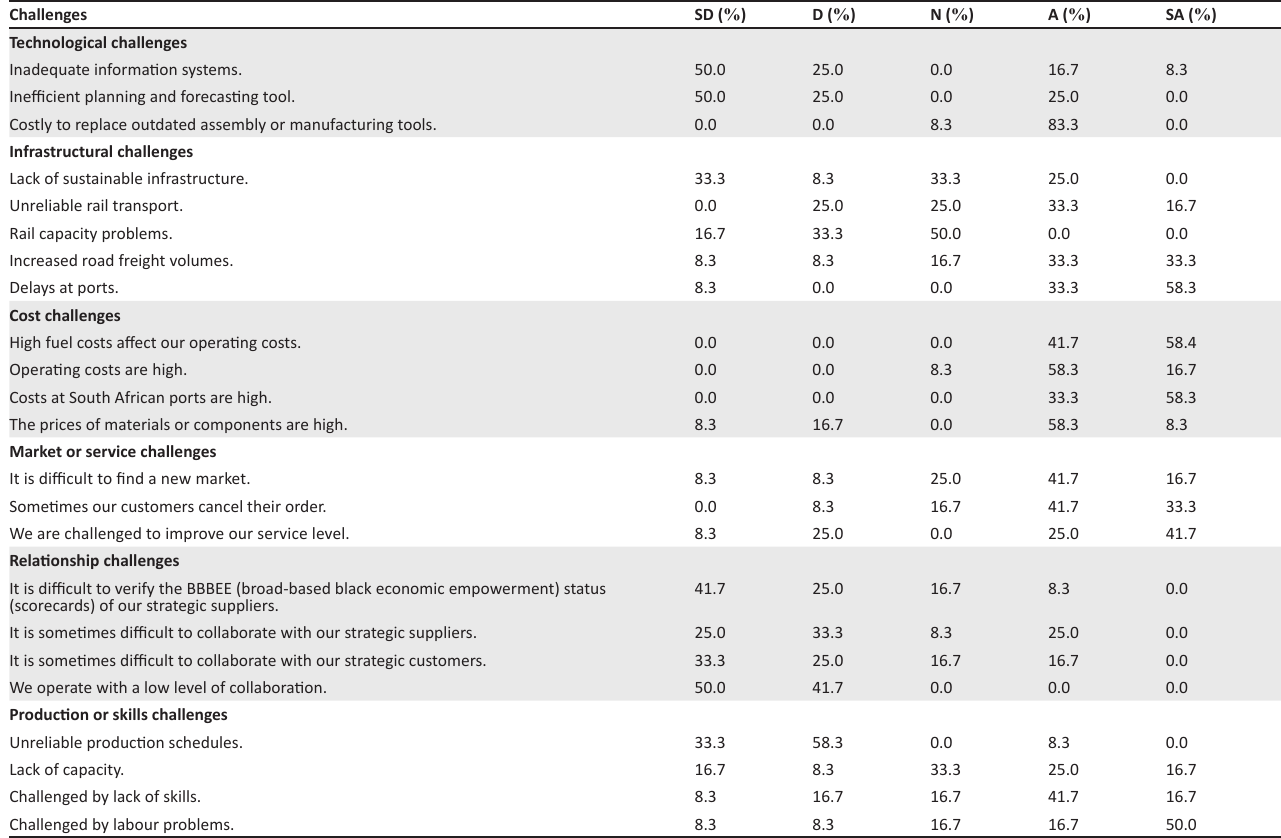
TABLE 1: Challenges experienced in locally-produced light vehicle supply